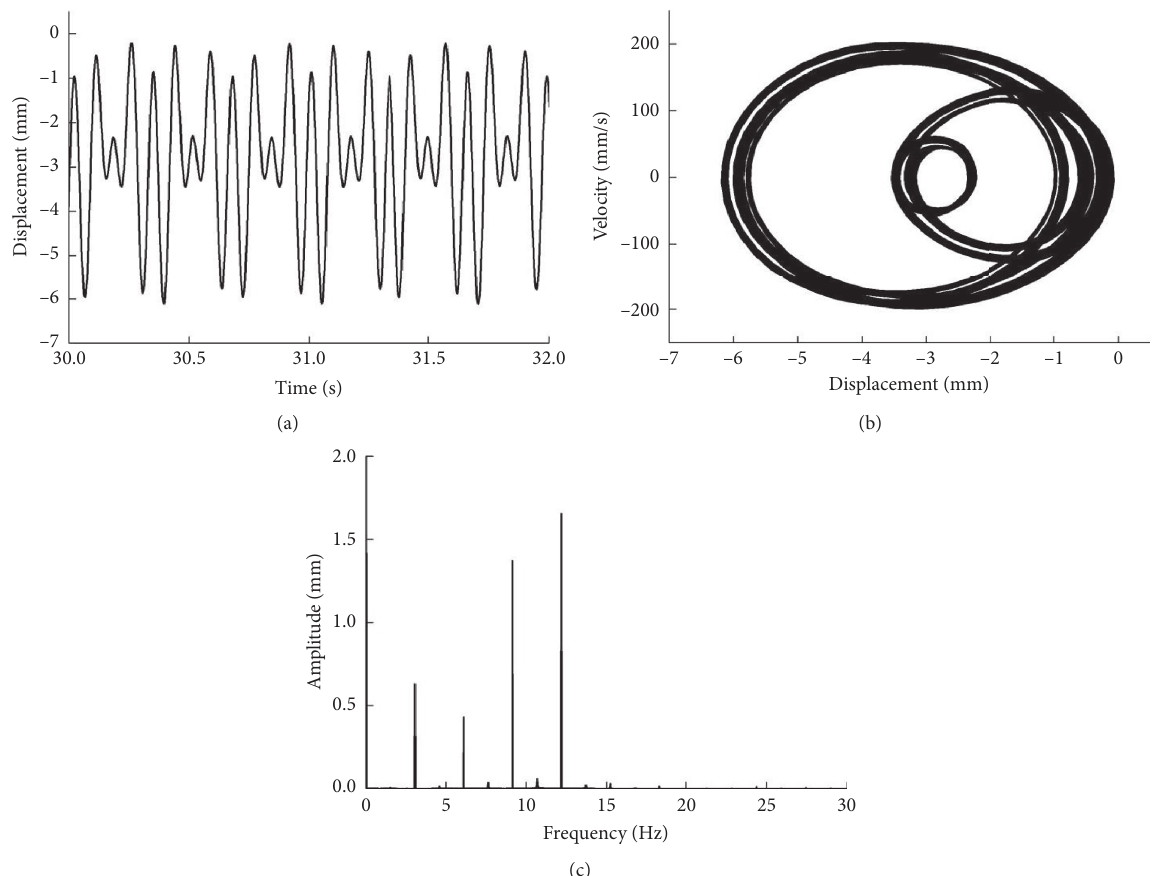
Figure 19: Multiperiod motion of the system is obtained for the external excitation frequency Ω � 12 . 2 Hz: (a) waveform; (b) phase portrait; (c) amplitude